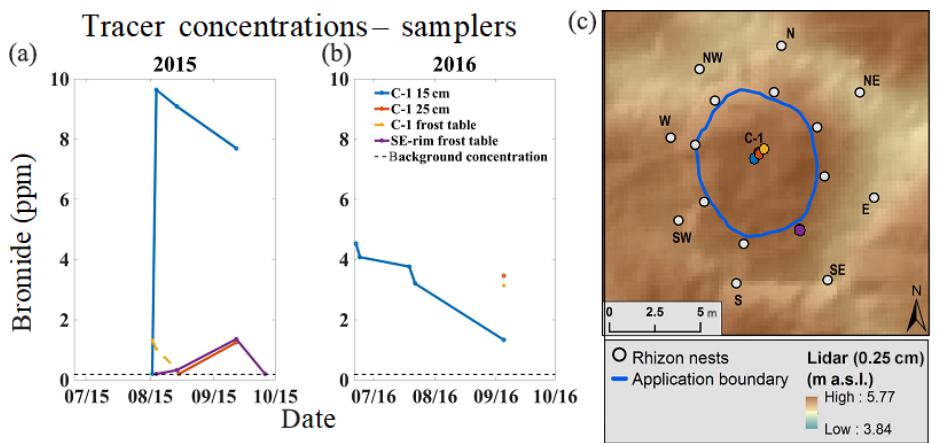
Figure 11. Tracer breakthrough curves for the high-centered polygon (a) and dots representing their corresponding locations (c) . The color of the dots correspond to the breakthrough curve of the same color. The blue line on the polygon digital elevation model (c) depicts the area of tracer